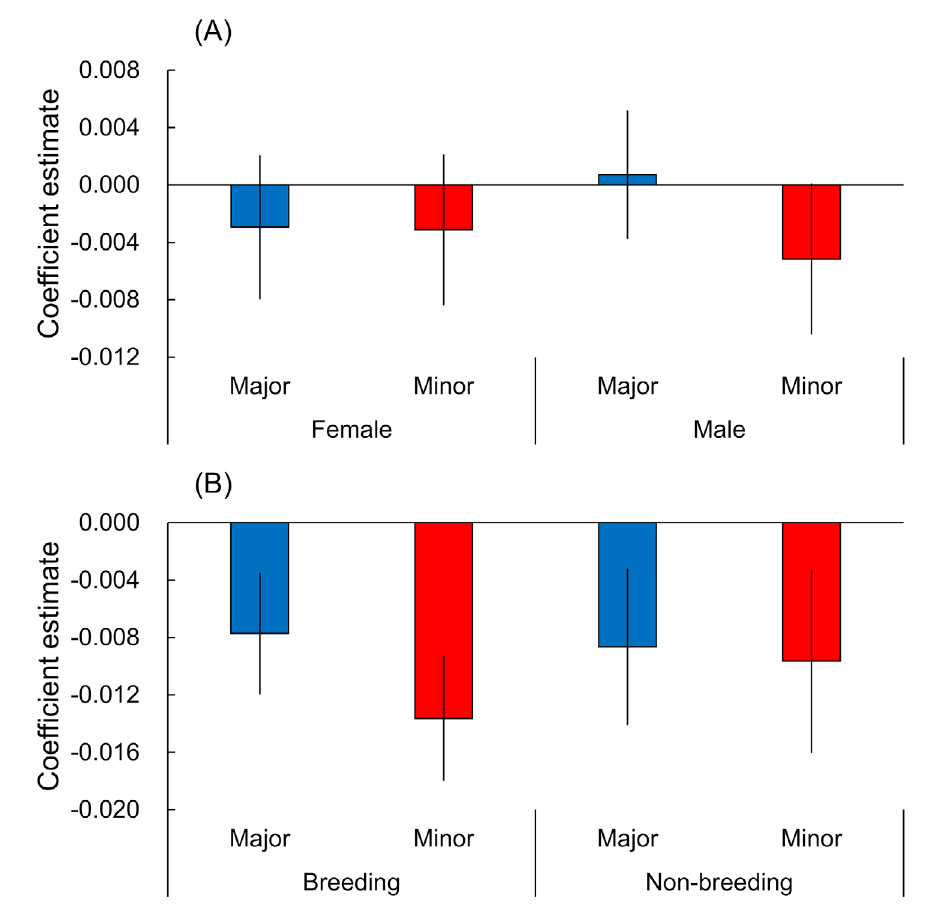
Figure 3. Intrasexual chela shape dimorphism between the breeding and non-breeding seasons in each sex (A) and intersexual chela shape dimorphism in the breeding and non-breeding seasons (B) for major and minor chelipeds of the porcellanid crab Petrolisthes japonicus , based on the respective log-transformed allometric growth equation models between propodus length (PrL) and propodus width (PrW) of the chelipeds: lnPrW = ln a + b lnPrL + c lnPrL × Season, where Season is the categorical explanatory variable [breeding season (May to September) or non-breeding season (October to April)] and lnPrW = ln a + b lnPrL + c lnPrL × Sex, where Sex is the categorial explanatory variable (female or male). The coefficient estimate for each explanatory variable, including the Season or Sex, was the output for the breeding season or male, representing changes in the response variable relative to the baseline category (non-breeding season or female), and thus also representing the degree of the intra-and intersexual dimorphisms in each cheliped type. Vertical lines indicate 95 % confidence